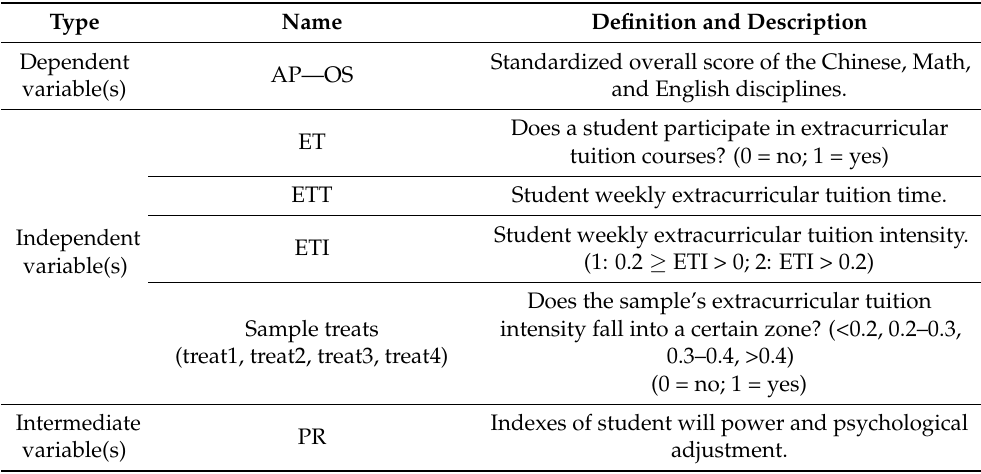
Table 1. Definition and description of